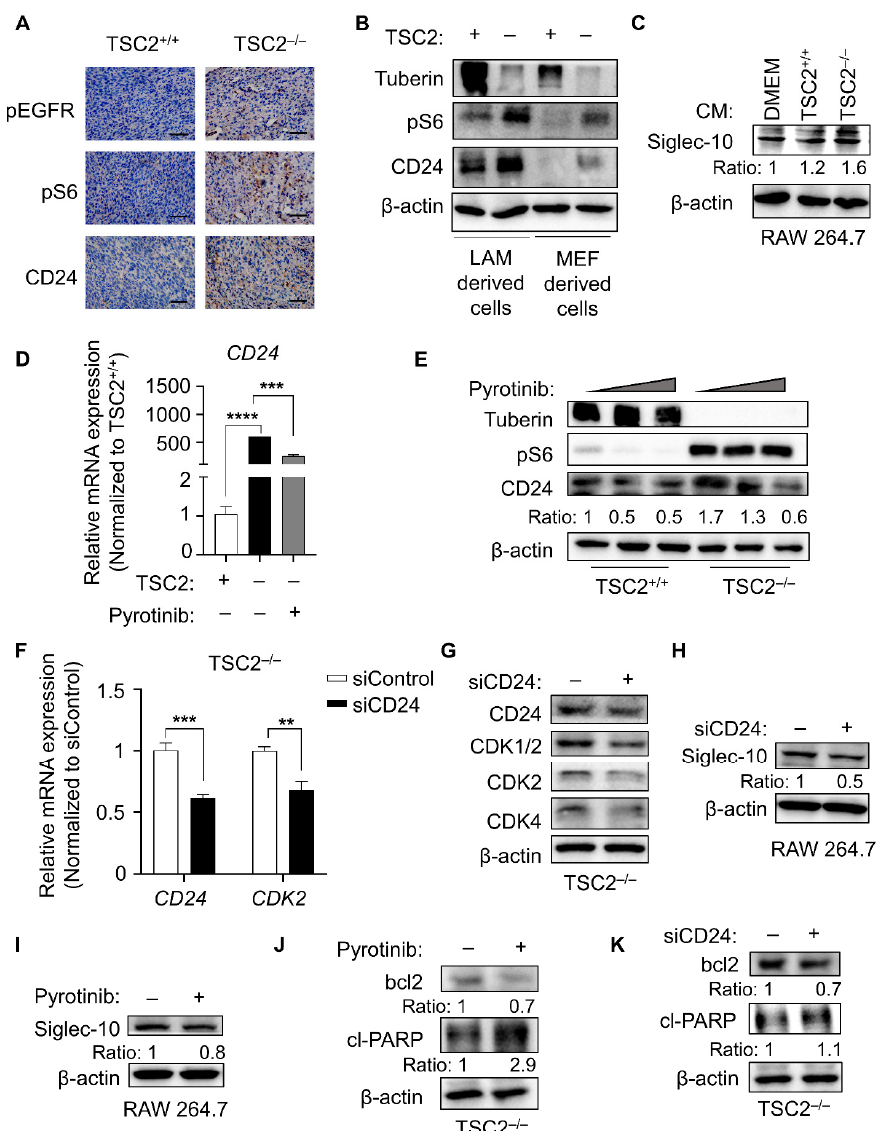
Figure 2. Elevated CD24 level promoted cell vitality of TSC2-deficient cells. ( A ) Immunohistochemical staining of pEGFR, pS6 and CD24 in tumor tissues, which were taken from nude mice following tumor bearing with MEF-derived cells (magnification 400 × , bar = 50 µ m). ( B ) Immunoblot analysis of proteins in LAM or MEF-derived cells. ( C ) Macrophages of RAW 264.7 were co-incubated with DMEM and culture supernatant of MEF with or without TSC2-deficient cells for 6 h, and RAW 264.7 cells were lysed, and siglec-10 was detected by immunoblot. ( D ) CD24 mRNA expression level was detected by qPCR ( n = 3) in MEF-derived cells treated with or without pyrotinib (1 µ M). **** p < 0.0001, TSC2 +/+ vs. TSC2 − / − . *** p < 0.001, TSC2 − / − vs. TSC2 − / − + pyrotinib, Student t test. ( E ) Immunoblot analysis of MEF-derived cells treated with or without pyrotinib (1 µ M or 5 µ M). ( F ) CD24 and CDK2 mRNA expression level was detected by qPCR ( n = 3) in TSC2-deficient cells transfected with siControl or siCD24. *** p < 0.001, siControl vs. siCD24 in the mRNA of CD24 . ** p < 0.01, siControl vs. siCD24 in the mRNA of CDK2 , Student t test. ( G ) Immunoblot analysis of proteins in TSC2-deficient cells transfected with siCD24 or not. ( H , I ) Macrophages of RAW 264.7 were co-incubated with culture supernatant of TSC2-deficient cells treated with or without siCD24 ( H ) or 1 µ M pyrotinib ( I ), and siglec-10 was detected by immunoblot. ( J , K ) Apoptosis-related protein was detected by immunoblot in TSC2-deficient cells treated with or without 1 µ M pyrotinib ( J ) or si CD24 ( K